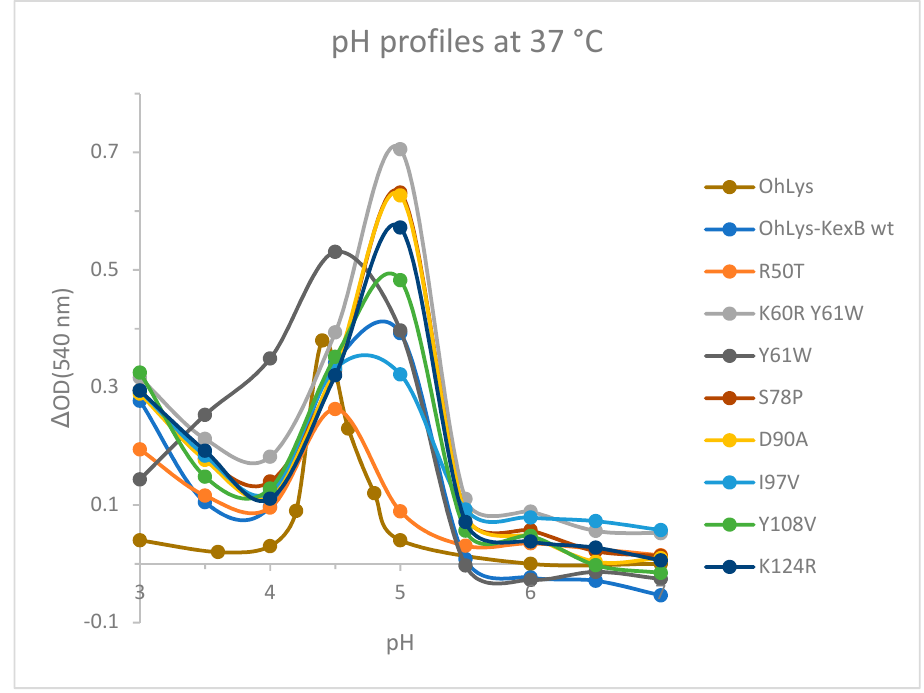
Figure 7. The pH profiles of wild-type Oh Lys, the Oh Lys-KexB wt, and a selected set of variants, all derived from Oh Lys–KexB.